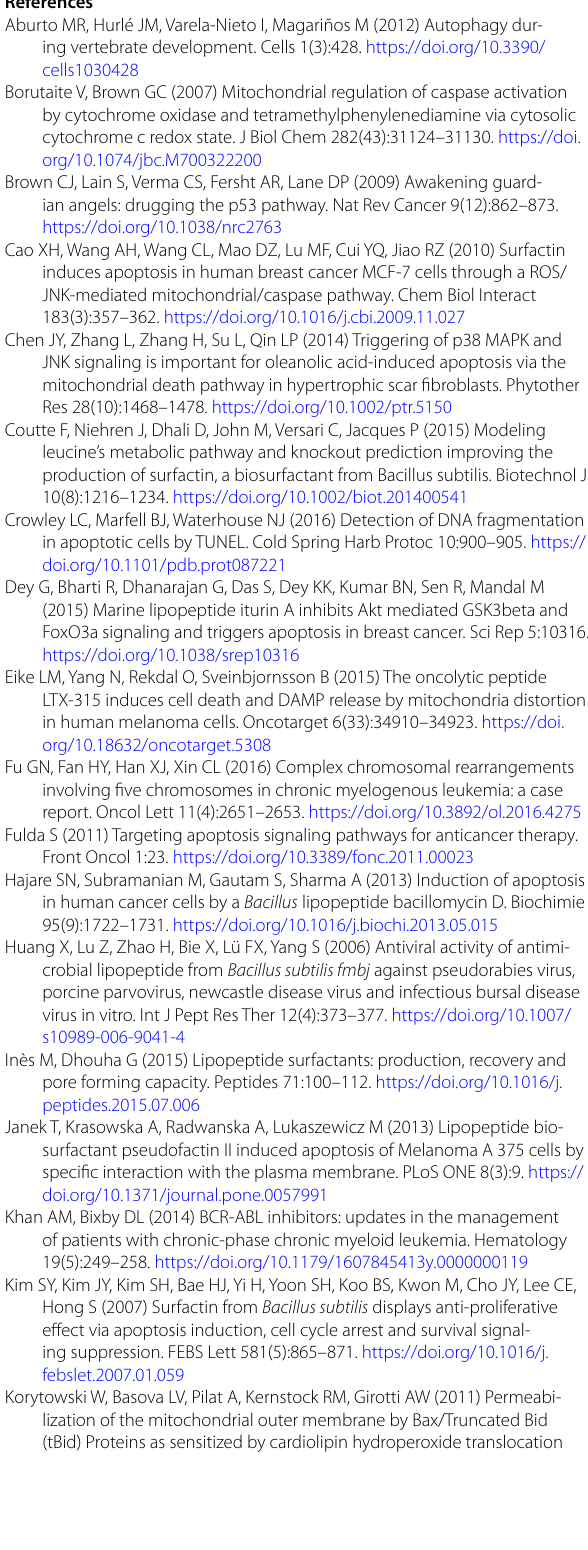
Additional file 1: Figure S1. Chromatogram of purification (a) and ESI-MS (b) of major anticancer active lipopeptide fractions. Figure